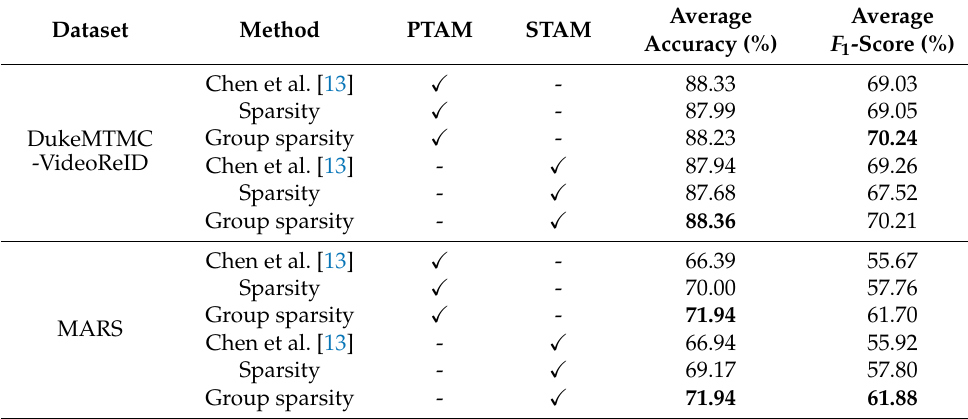
Table 5. Comparisons between the sparsity-based and group-sparsity-based (ours) constraints for the occlusion samples of the DukeMTMC-VideoReID and MARS datasets. The bold indicates the best